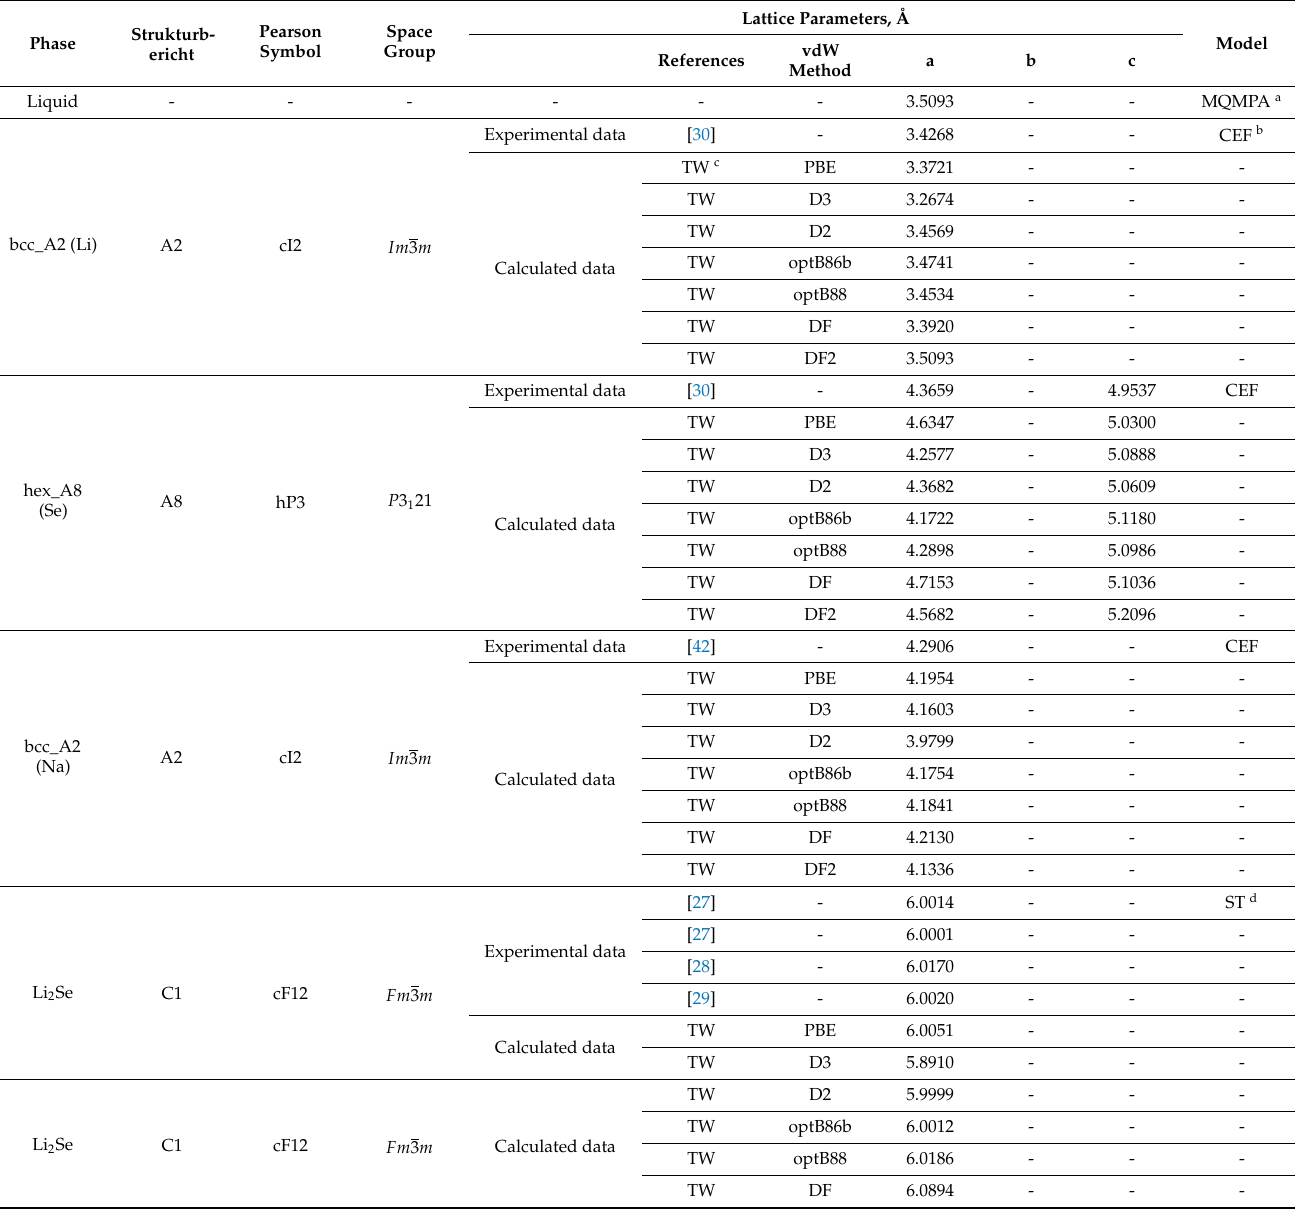
Table 1. Structural parameters of phases and thermodynamic models used in the present